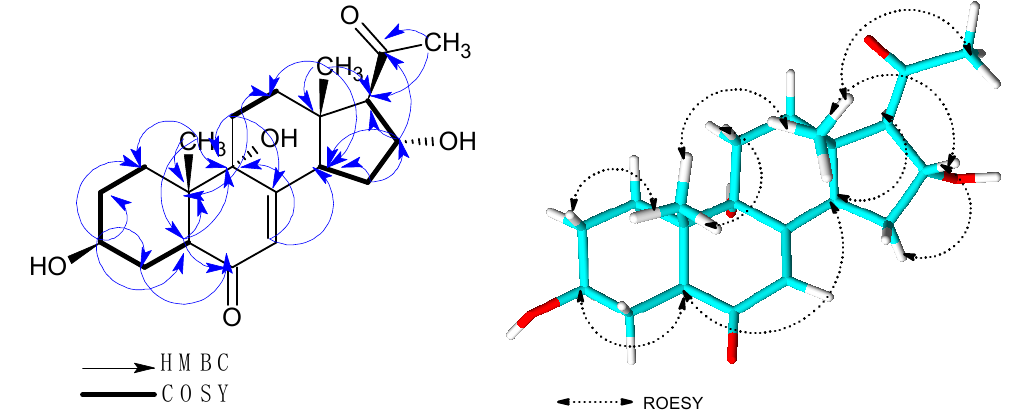
Figure 1. Chemical structures of 1 – 5 .